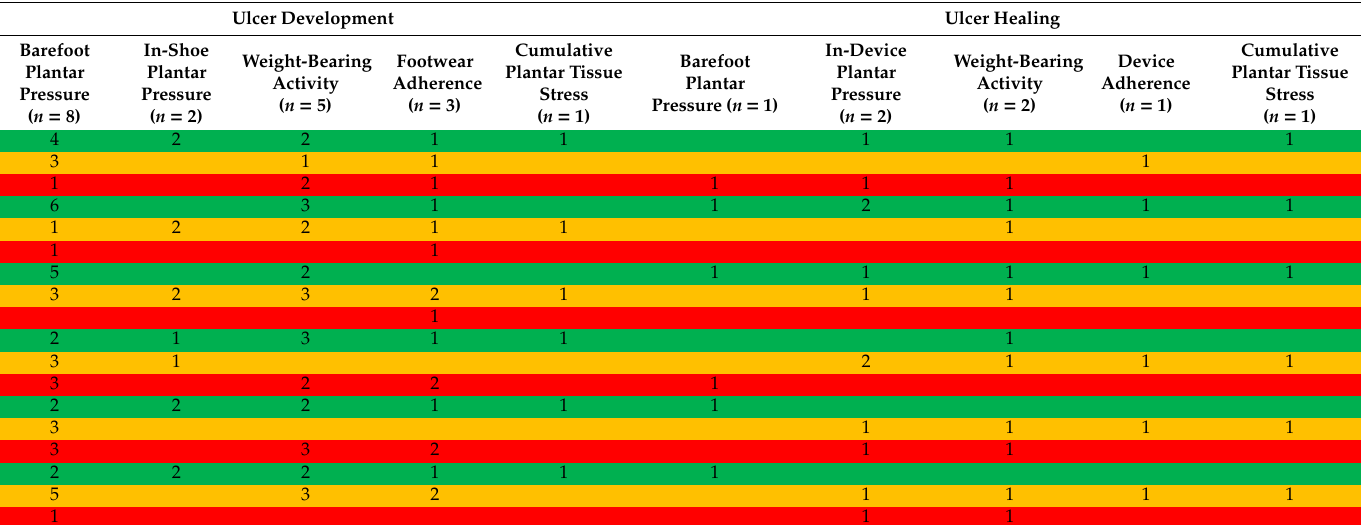
Table 2. QUIPS risk of bias score per foot-loading factor and primary